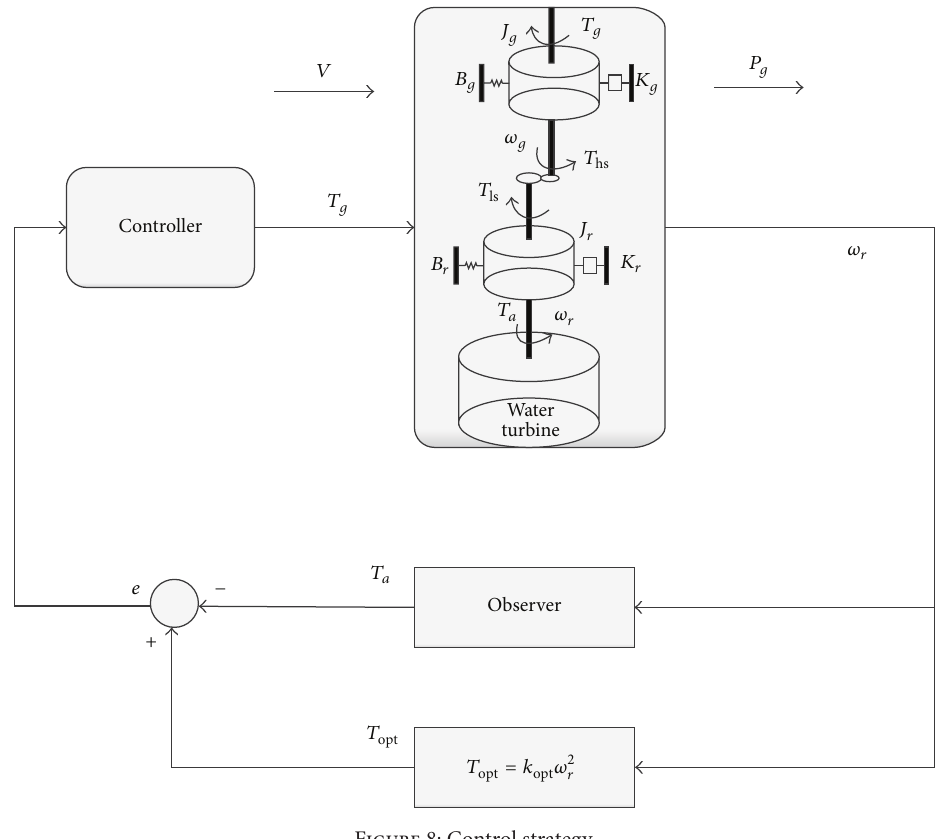
Figure 8: Control